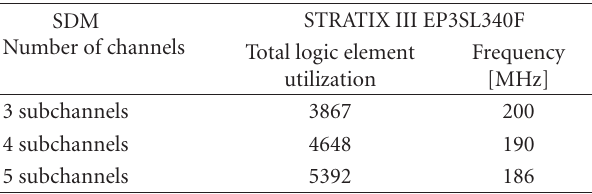
Table 3: Synthesis results SDM router (10 bits per subchannel).